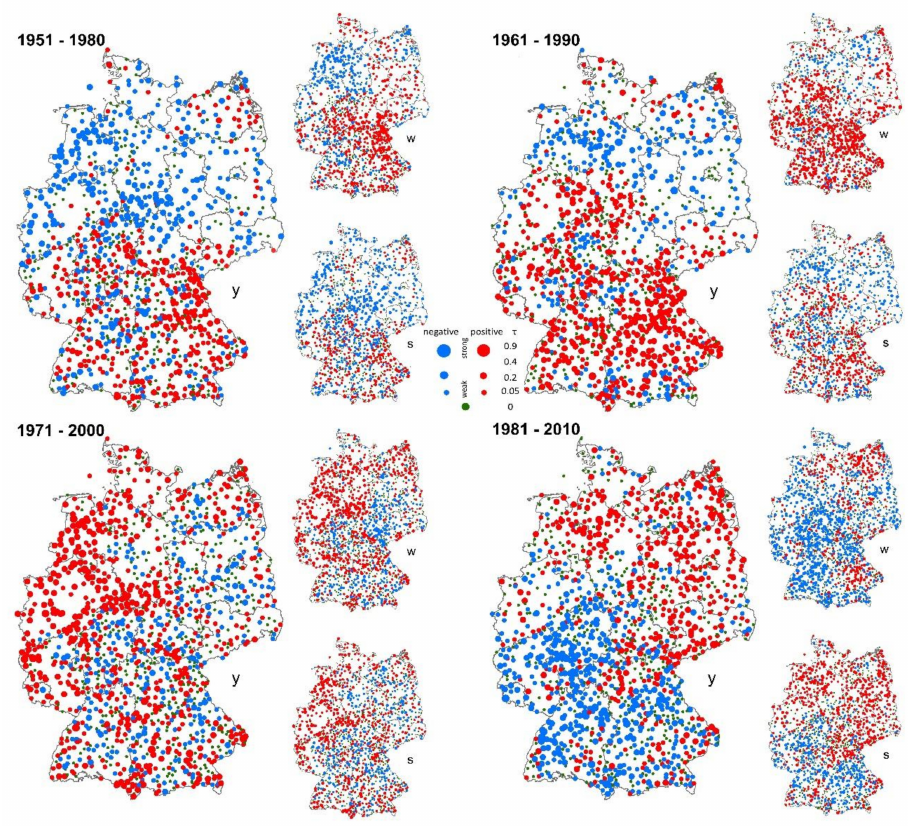
Figure 6. Increasing (red) and decreasing (blue) trends of heavy rainfall days with ≥ 20 mm at rainfall stations, for years (y), summer (s), and winter (w). For the sake of readability, the maps show only the active stations and four CLINO